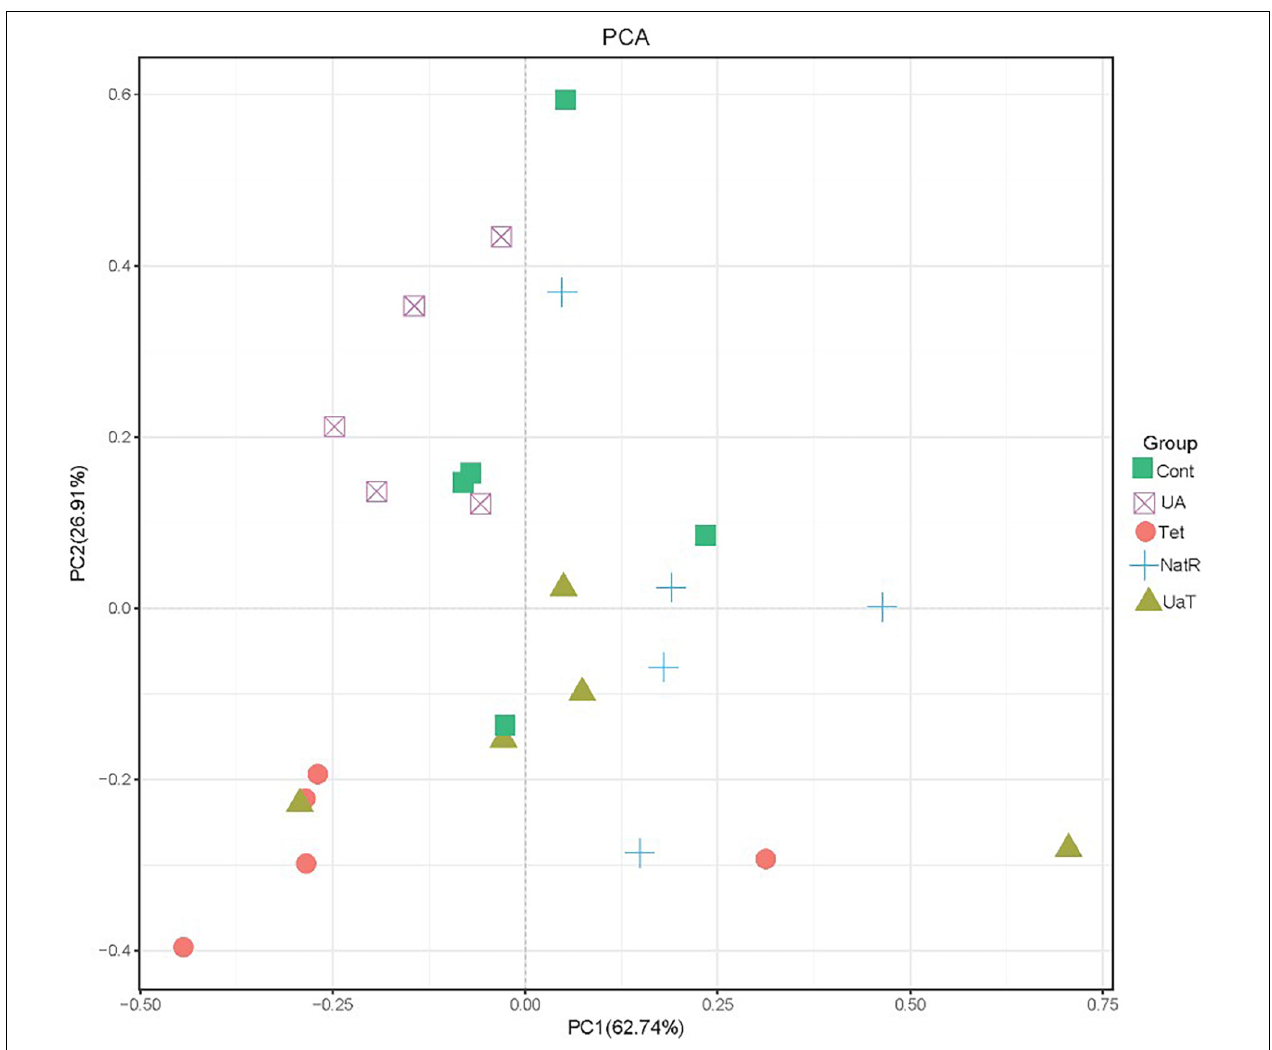
FIGURE 7 | Principal component analysis (PCA) of the structure of the gut microbiota. All group names correspond to those described in the legend of Figure 2